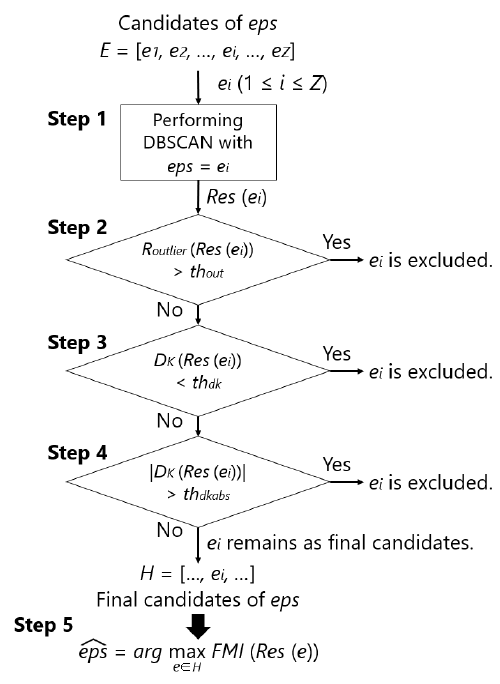
Figure 7. Flowchart of the (cid:99) eps search